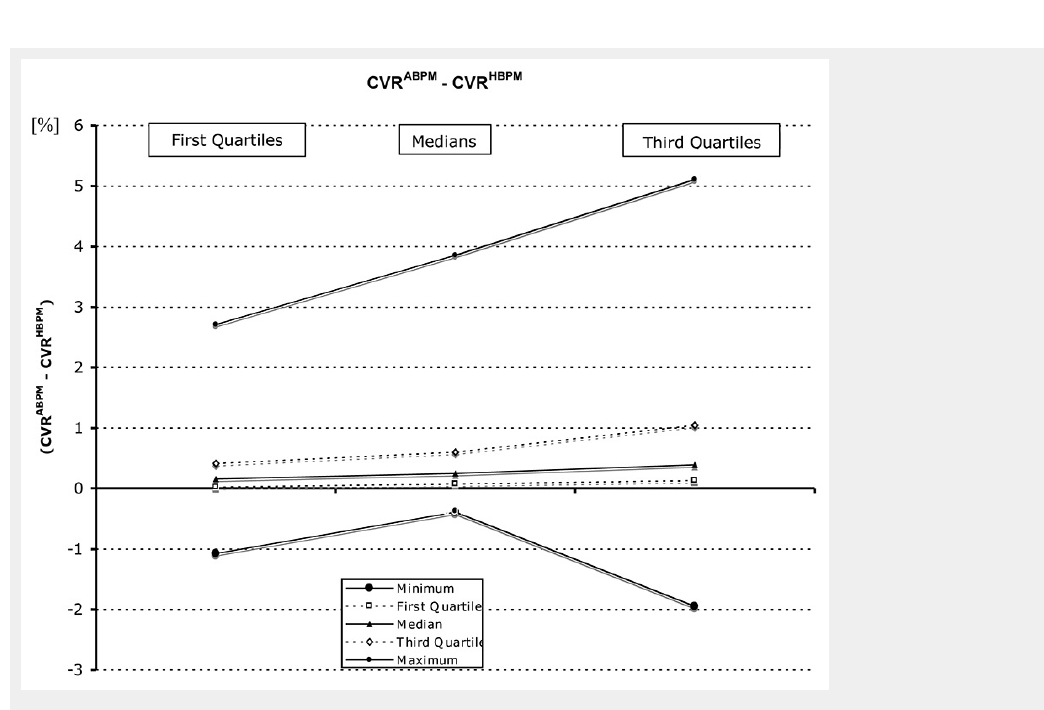
Figure 2 Average differences of measurements based on ABPM and HBPM (CVR ABPM - CVR HBPM ), calculated for the first quartile, median and third quartile of all patients. ABPM = ambulant blood pressure measurement; CVR = cardiovascular risk; HPBM = home blood pressure